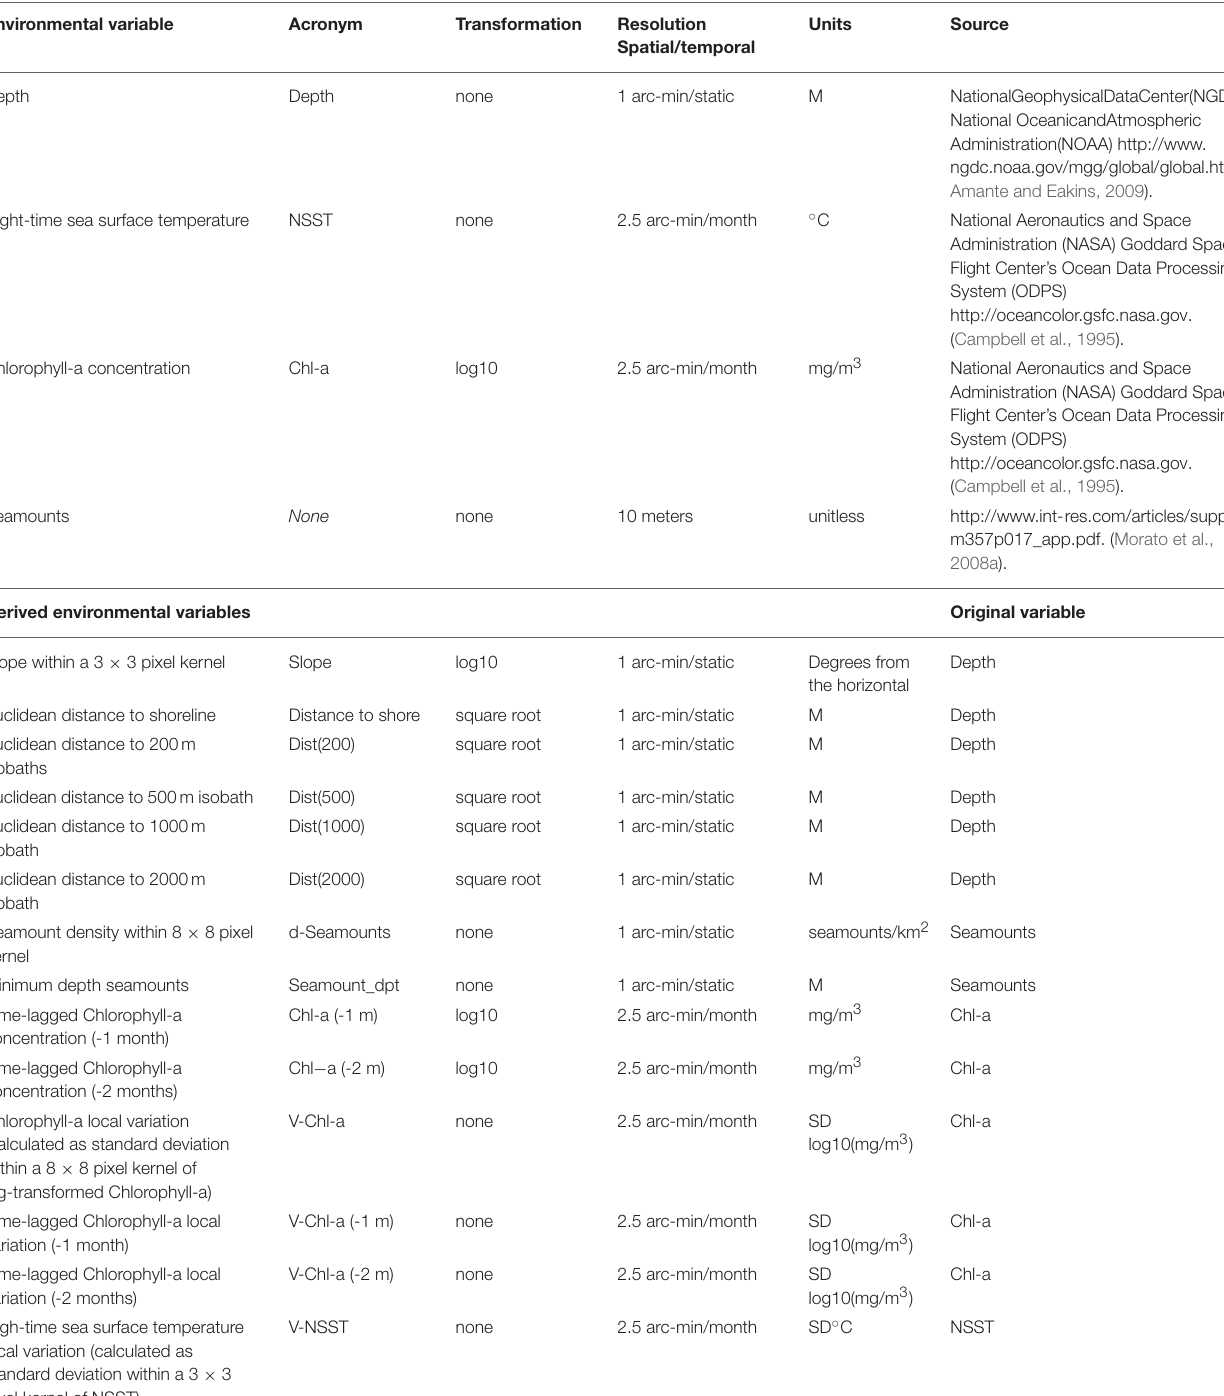
TABLE 1 | Candidate environmental variables used in the variable selection procedure prior to model fitting (see Supplementary Material S1 for details). Environmental